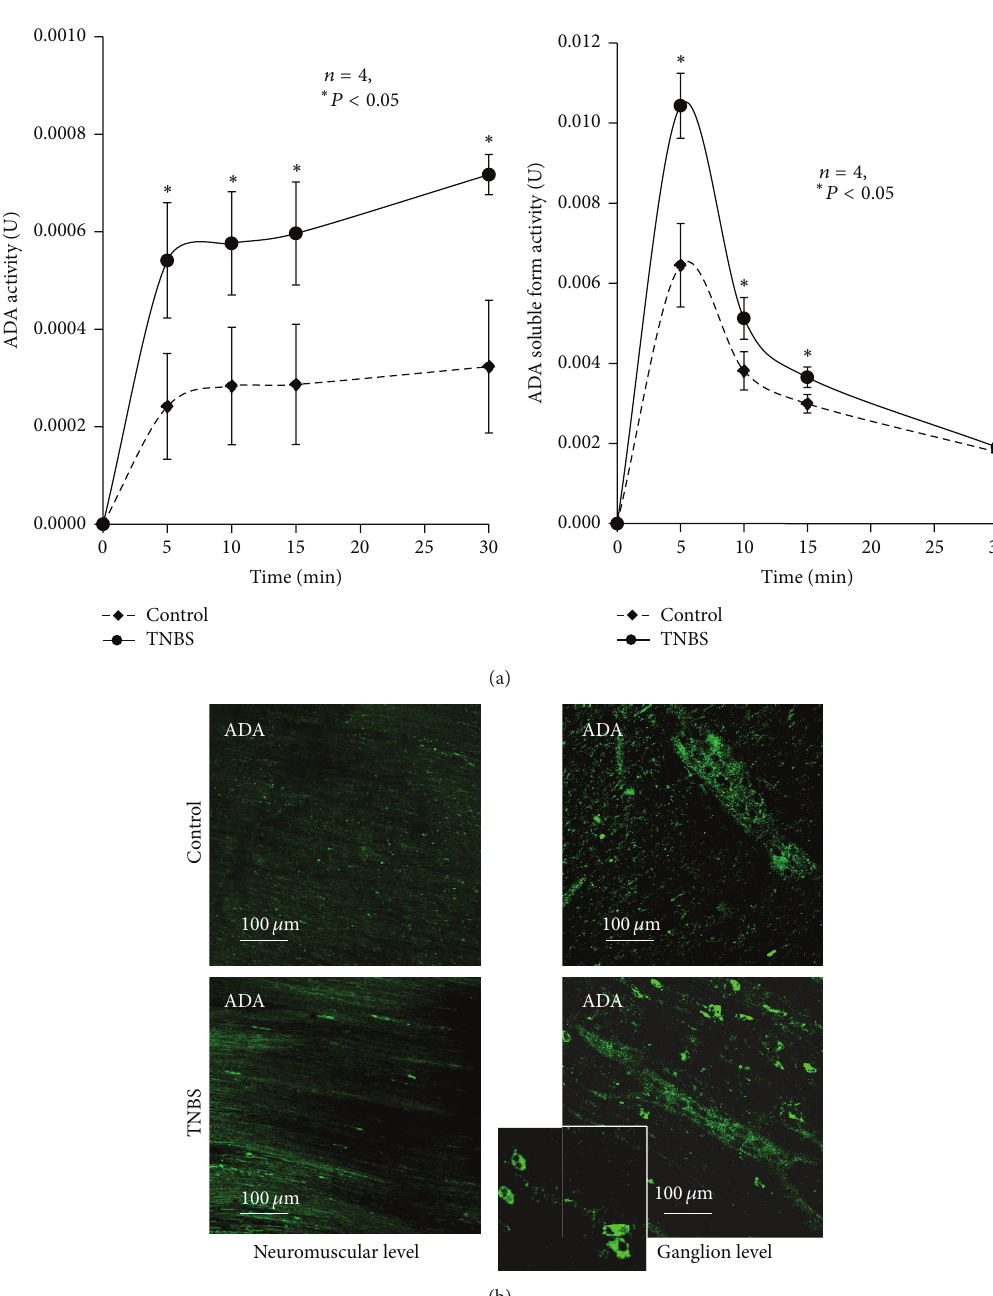
Figure 9: (a) Activity of ADA during the extracellular catabolism of adenosine in the LM-MP of the ileum of control and TNBS-injected rats. Adenosine (30 𝜇 M) was incubated at zero time. Average results obtained in four experiments; the vertical bars represent the SEM and are shown when they exceed the symbols in size. ∗ 𝑃 < 0.05 (one-way ANOVA followed by Dunnett’s modified t -test) represent significant differencesascomparedtocontrolanimals.(b)LocalizationofADAimmunoreactivityinsingleconfocalimagesofwhole-mountpreparations of the longitudinal muscle-myenteric plexus of the ileum of control and TNBS-injected rats, taken both at ganglia and neuromuscular layers. Please note that ADA immunoreactivity is much more exuberant in preparations from TNBS-treated rats than in control animals. The figure insert details ADA staining in mononuclear inflammatory cells infiltrating myenteric